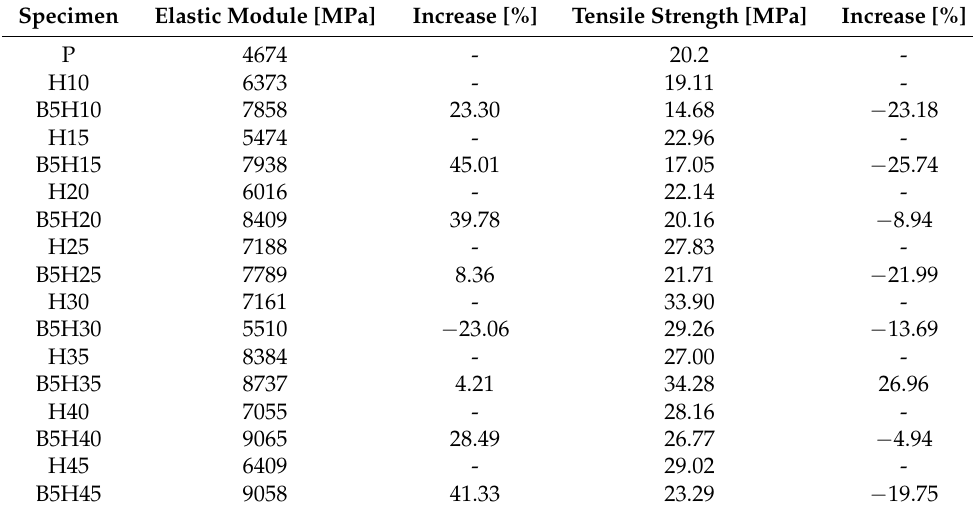
Table 5. Summary of the results of the tensile